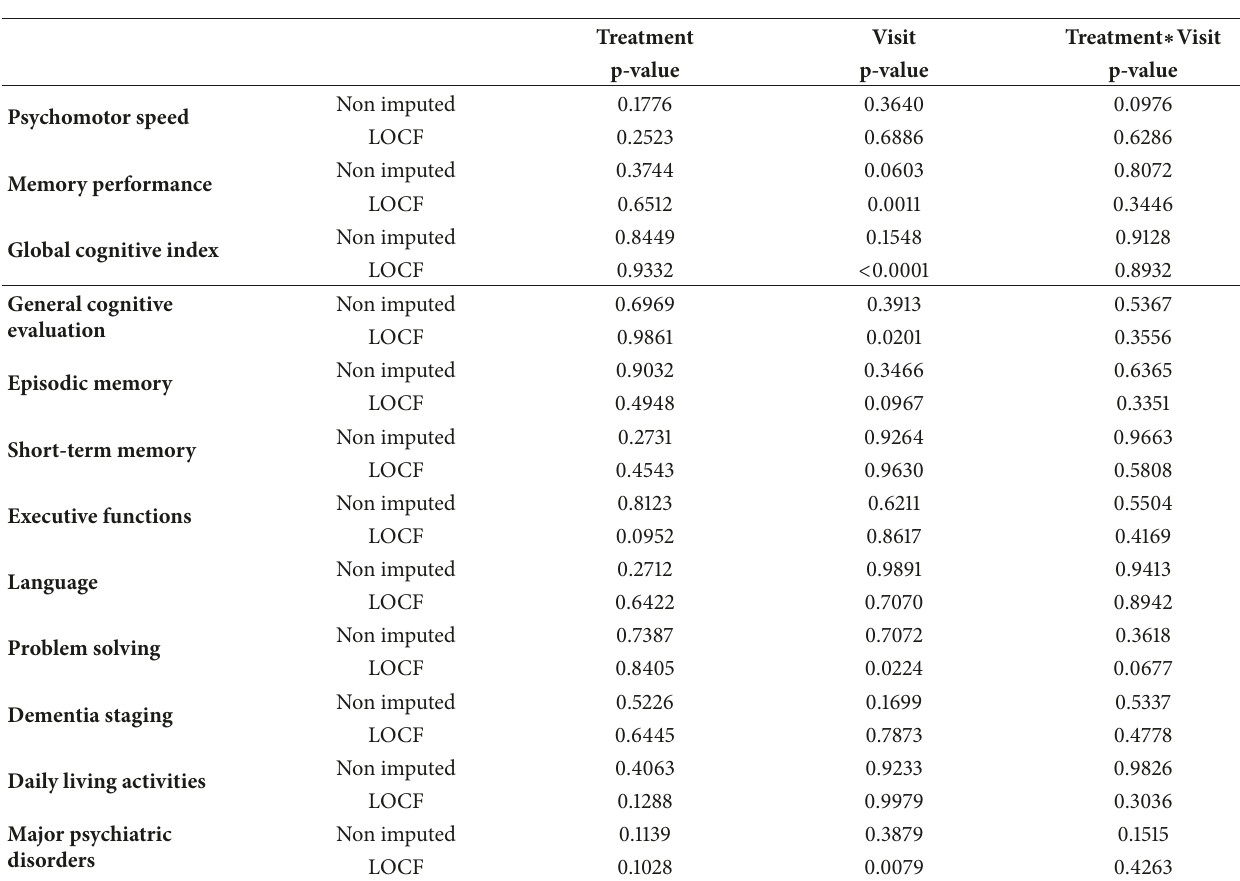
Table 6: ANOVARM models on cognitive domains.